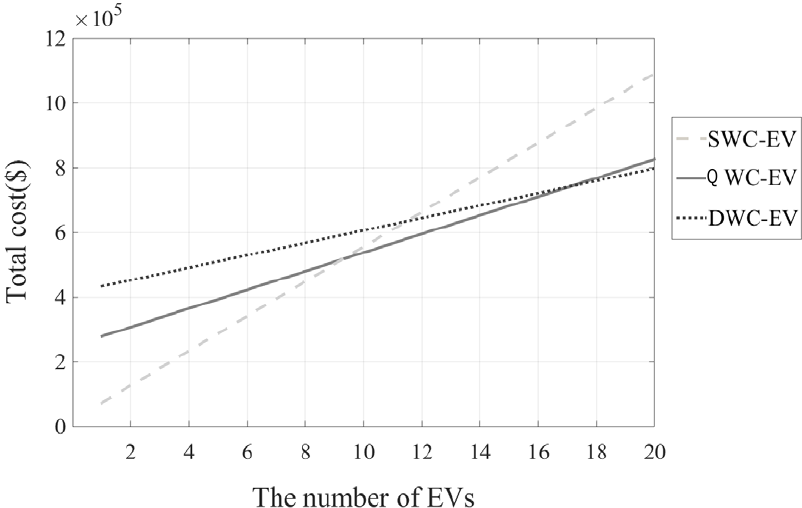
Figure 13. Economic fleet-scale analysis for the Gumi City